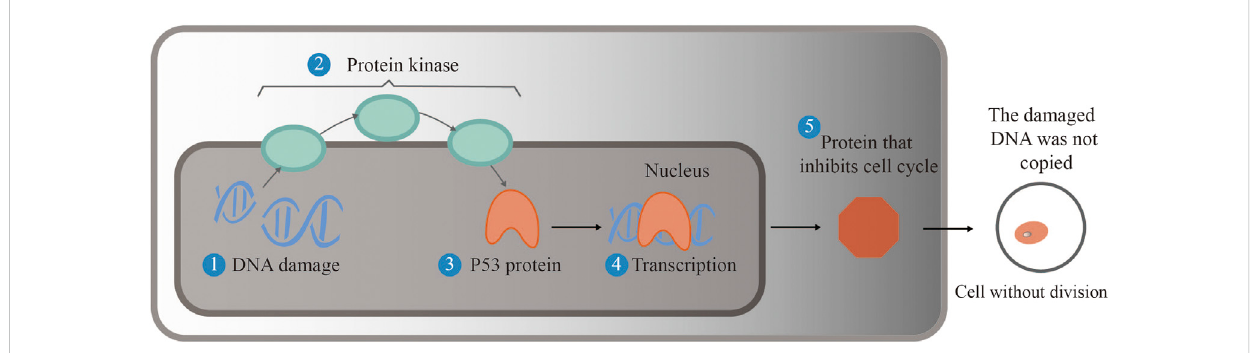
FIGURE 6 Selenium activates the p53 gene and inhibits cell carcinogenesis. When DNA is damaged, protein kinase activates the p53 gene to translate into a protein that repairs the damaged DNA, thereby halting the cell cycle. If the DNA is seriously damaged, apoptosis is activated to ensure that faulty DNA does not replicate, preventing the cell from becoming